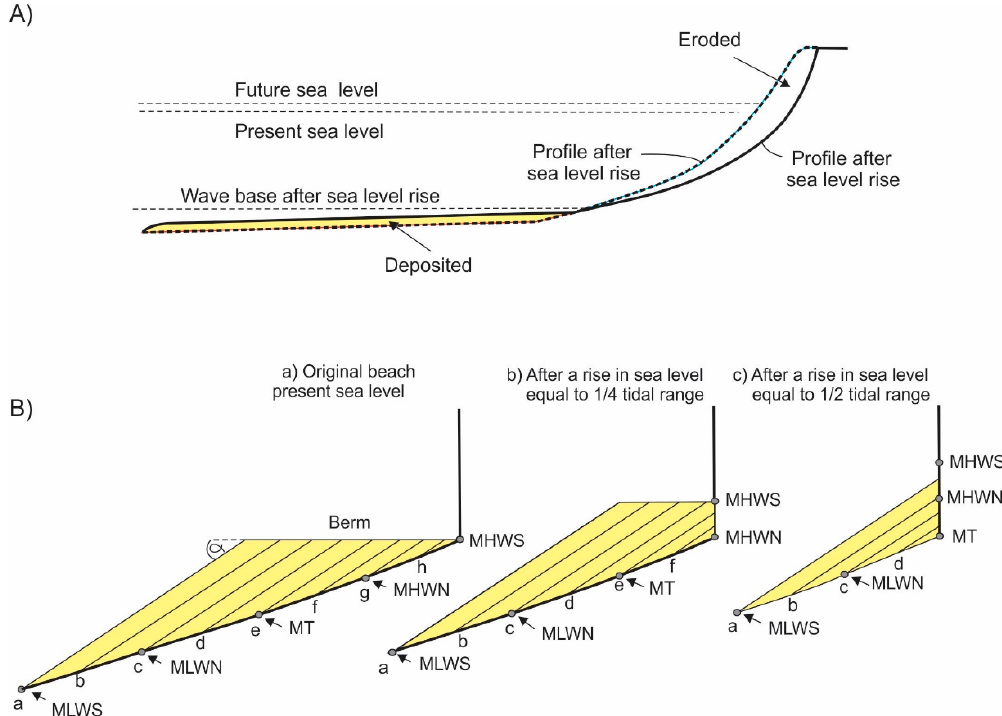
Figure 3. ( C ) Conjectural representation of wave energy expenditure within the intertidal and supratial zone as a function of: ( B ) The tidal duration distribution (wave frequency at each elevation); and ( A ) the effect of tidal modulation and storm surges on individual wave energy and elevation. MHWN, MT, and MLWN refer to mean high water neap, mid-tide, and mean low water neap tidal levels, respectively.